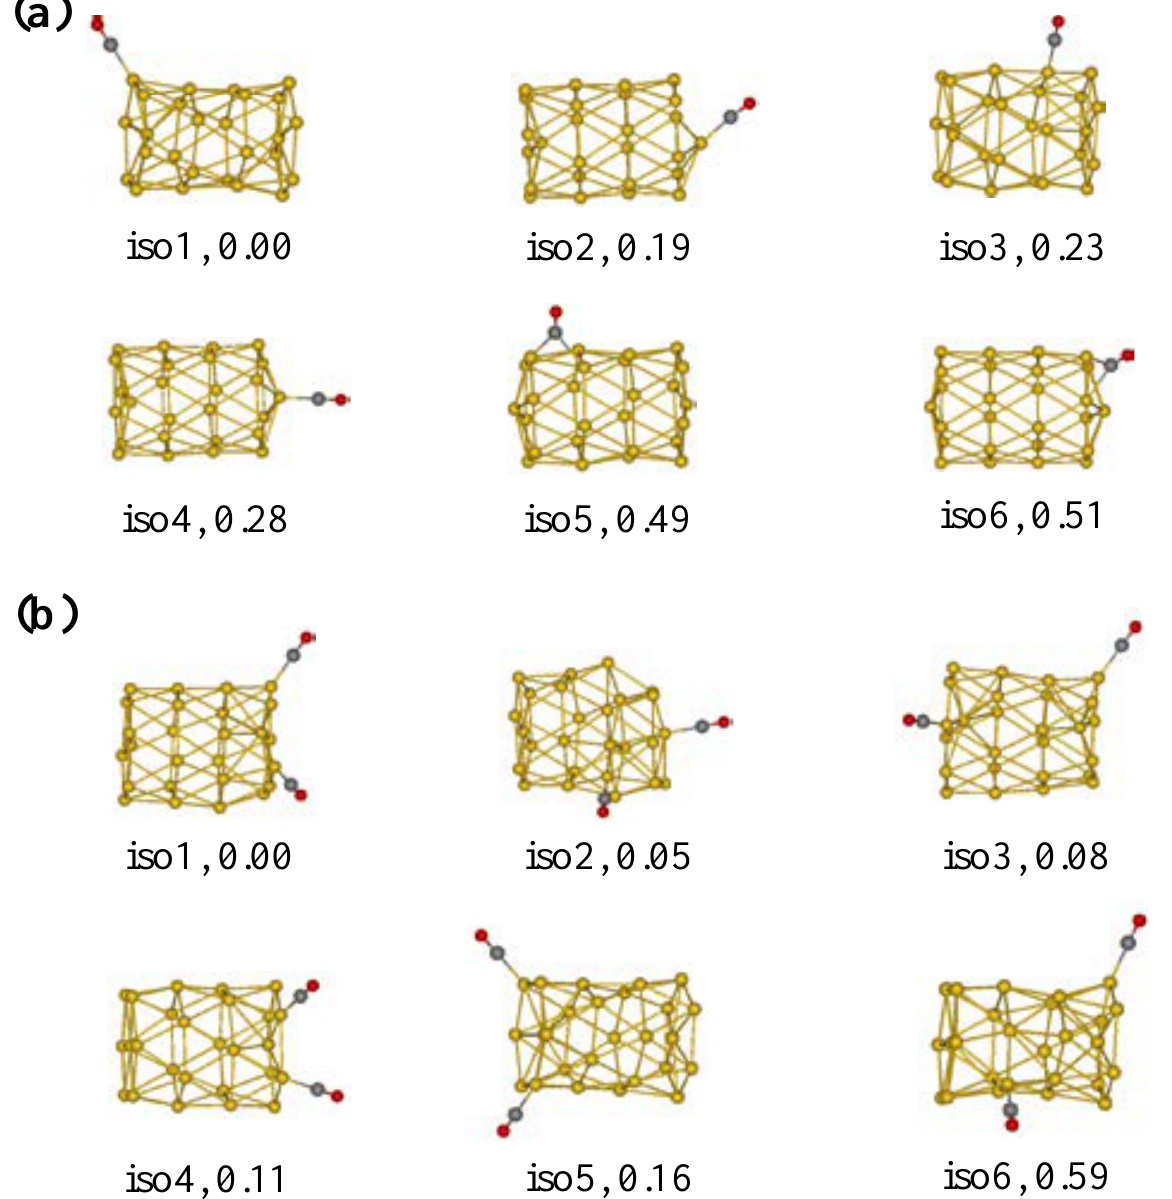
Figure 1. Isomer structures and relative stability of ( a ) Au 26 -CO and ( b ) Au 26 -(CO) 2 . Au, yellow; C, grey; O, red (supplementary materials) .